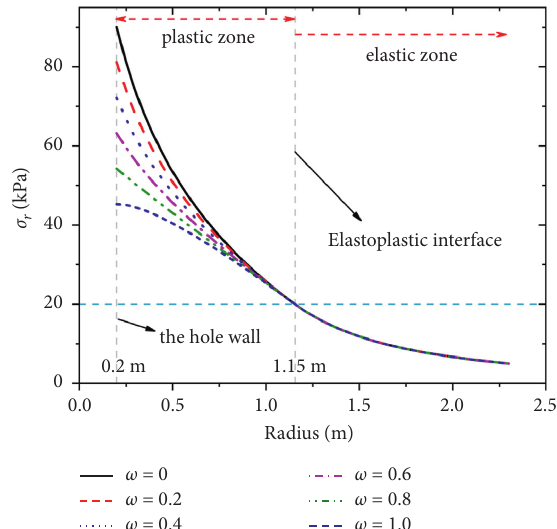
Figure 7: Radial stress distribution.